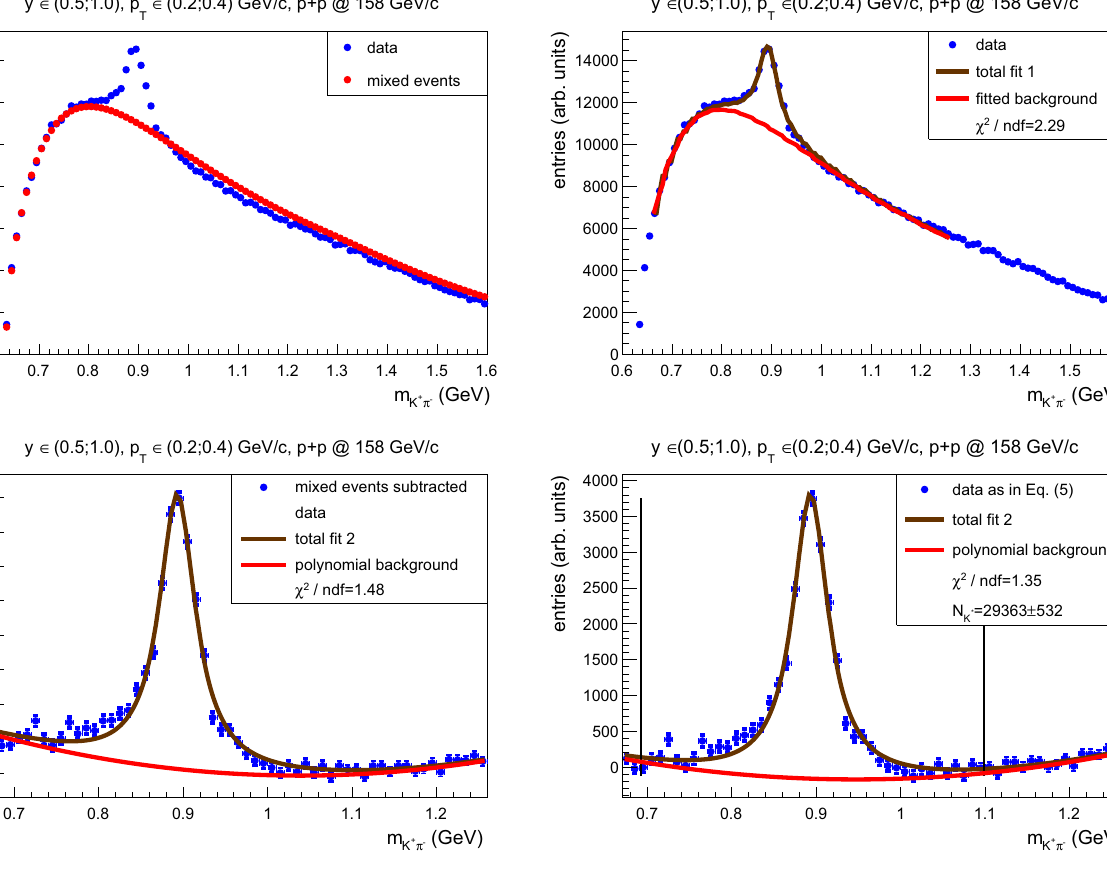
Fig. 4 Theexampleoftheprocedureofsignalextractionfor K ∗ ( 892 ) 0 in rapidity bin 0 . 5 < y < 1 . 0 (all rapidity values in the paper are given in the center-of-mass reference system) and transverse momen- tum bin 0 . 2 < p T < 0 . 4 GeV / c for p+p collisions at 158 GeV / c . Top, left: data signal (blue points), and background histogram (red points) obtained from mixed events (standard method). Top, right: data signal